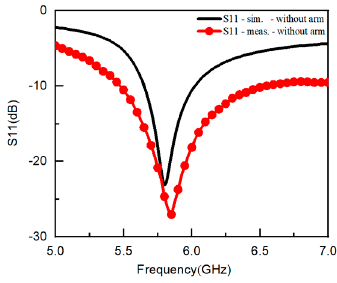
Figure 8. The simulated and measured S11s.